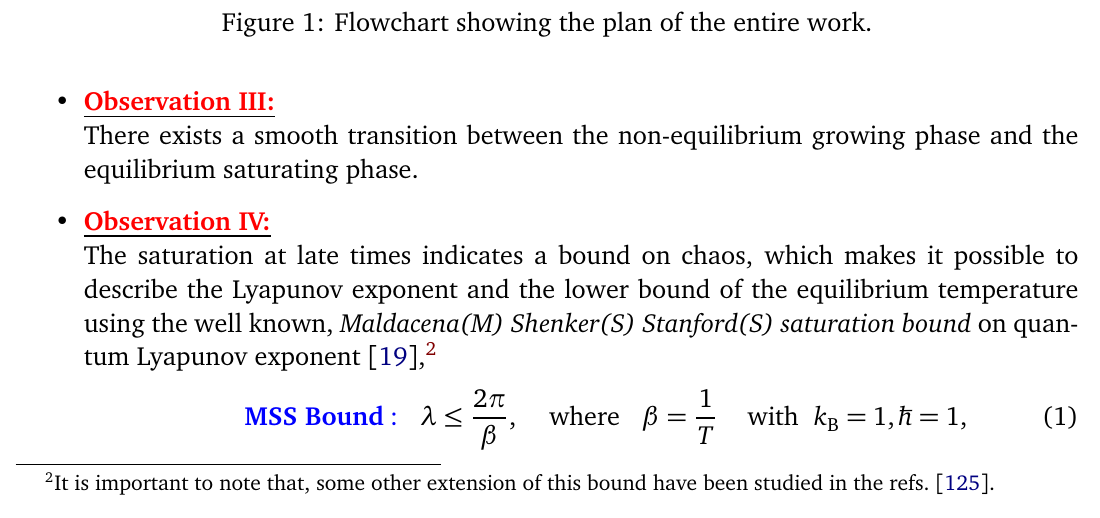
Figure 1: Flowchart showing the plan of the entire